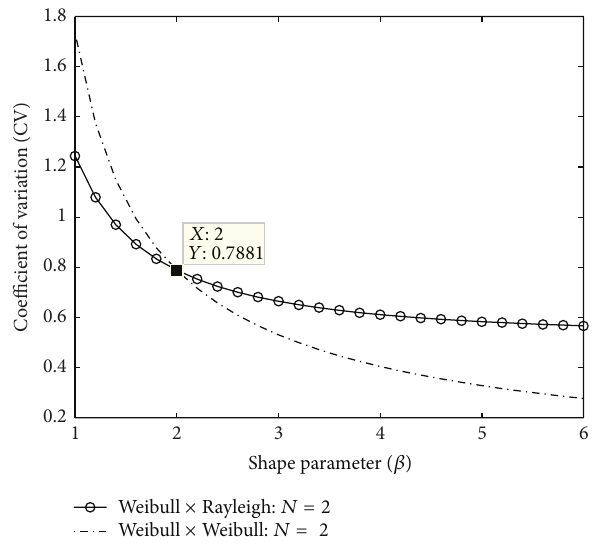
Figure 3: Channel variability comparison for heterogeneous and homogeneous compound